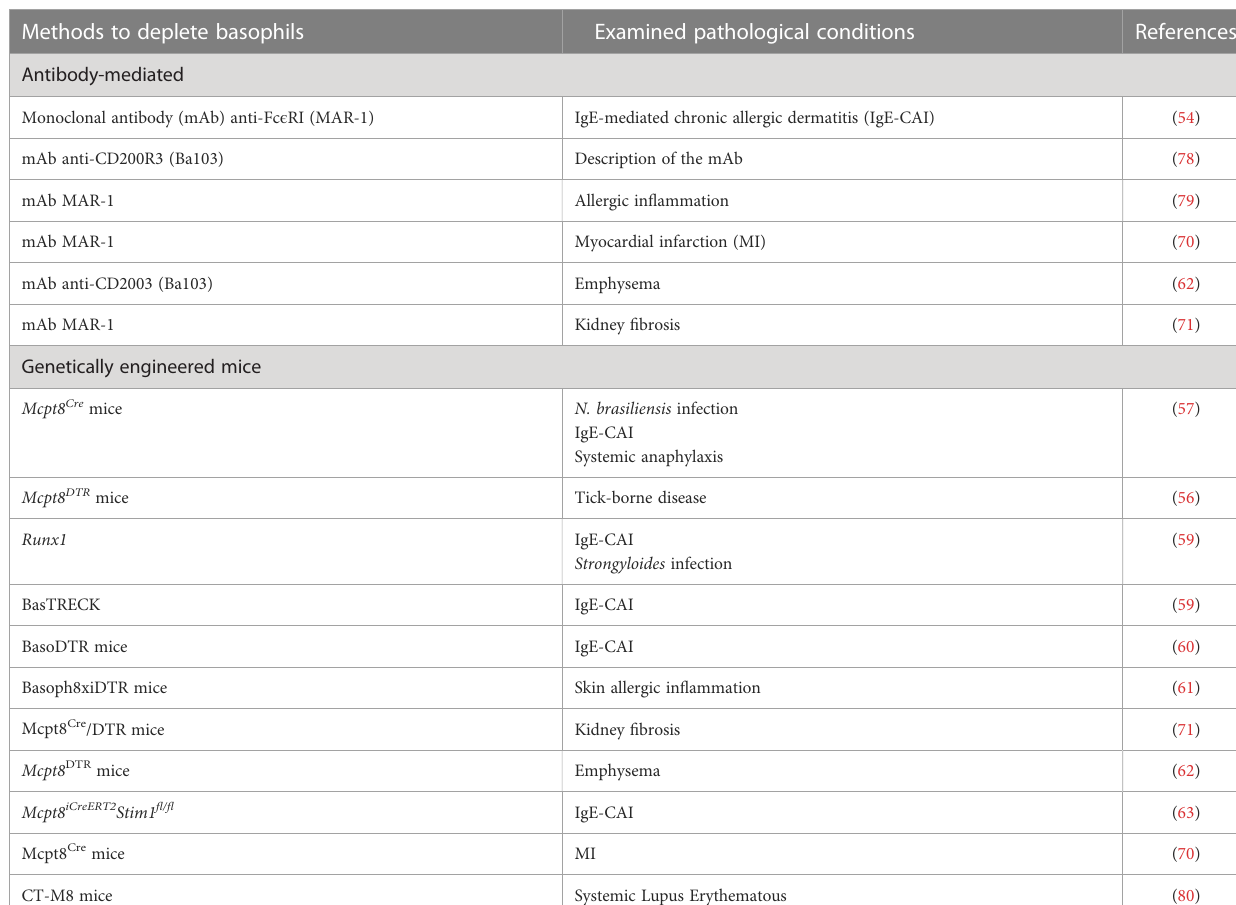
TABLE 1 Antibody-mediated and genetic depletion models for the in vivo study of basophils in different pathological conditions. Methods to deplete